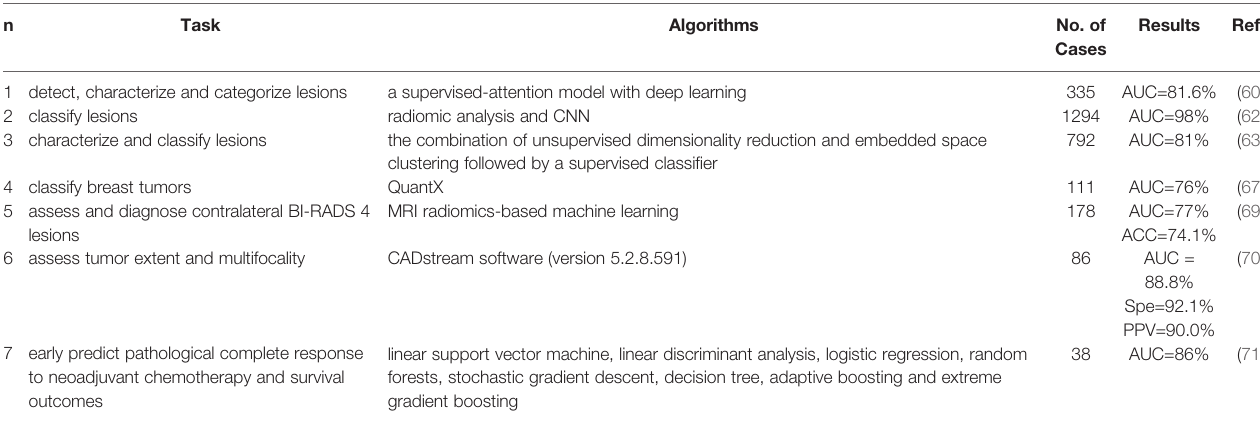
TABLE 3 | Summary of key studies on the role of AI in breast MRI.